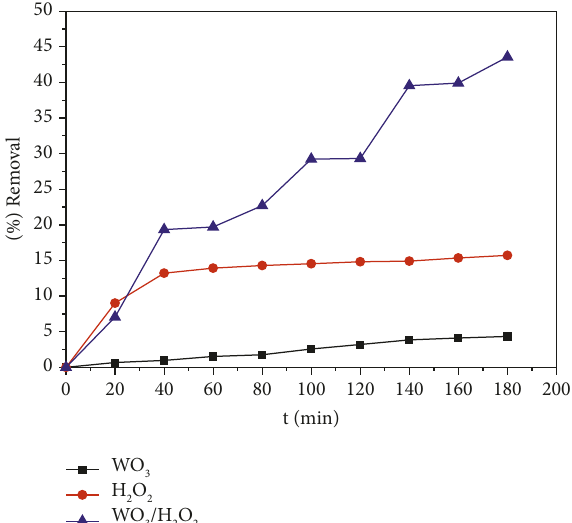
Figure 3: Effect of catalysts on the rate of removal of MO: experimental condition: pH � 4, (OM) � 30mg L − 1 , V mass of WO 3 � 0.25